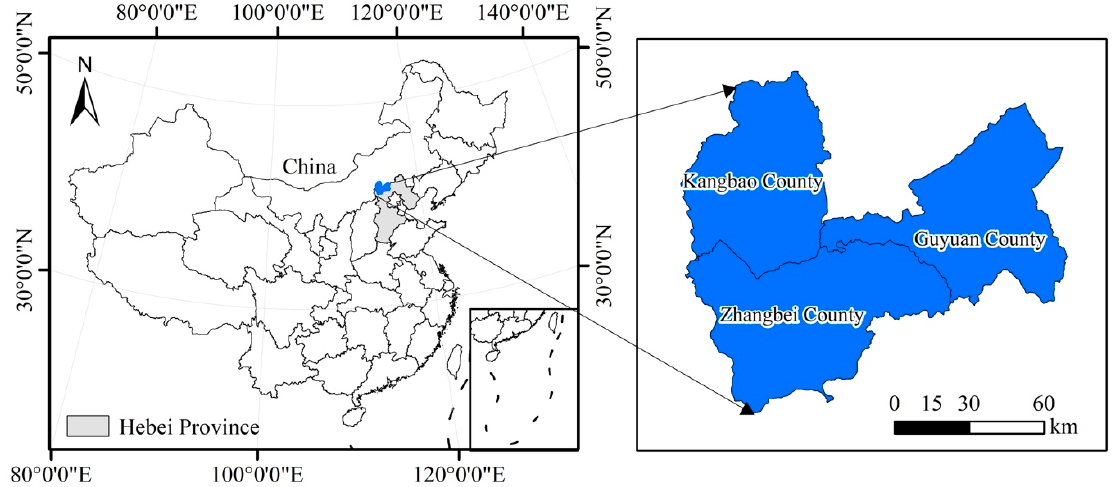
Figure 1. Map showing the location of the study area. The study area belongs to the agro-pastoral transitional zone of Northern China. Ani- mal breeding and agriculture coexist. The crops planted in this area are mainly naked oat, flax ( Sesamum indicum ), silage corn ( Zea mays ), potato ( Solanum tuberosum ), cabbage ( Brassica oleracea ), etc. The planting pattern of agriculture mainly includes the diversified plant- ing pattern and intensive planting pattern. The former is a small-scale peasant economy planting model with a long history, with each family planting a small area of farmland sepa- rately. The latter is a modern intensive mechanized large-scale single crop planting pattern. Some farmers in this region have transferred farmland to enterprises, and enterprises have centralized and unified the management of large areas of land for agricultural production, forming an intensive planting pattern. Some farmers have retained their own farmland and planted different crops according to their needs, forming a diversified planting pattern. The farmland with different crops forms different landscape units. The main crop of this region, naked oat, is present in both planting patterns (Figure 2). The shorter side or the width of single-planted naked oat land is usually greater than 100 m (Figure 2a), and the shorter side of diversified naked oat land is usually approximately 10 m (Figure 2b). The longer side of both of them is about 200 m. There are significant differences in crop diversity between the two planting patterns at the landscape level. There are on average 12.83 ± 0.93 crop types under the diversified planting pattern, but only one under the intensive planting